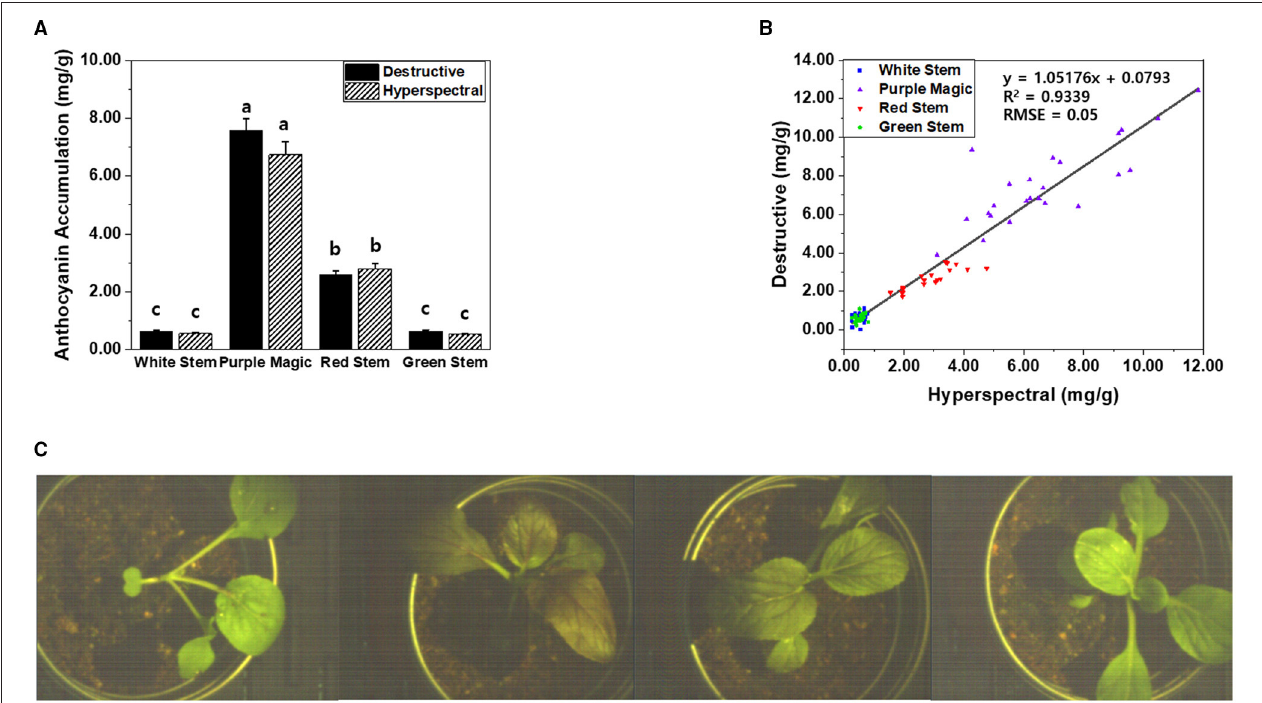
FIGURE 5 | (A) Comparison of anthocyanin accumulations (mg/g DW) obtained by destructive analysis and hyperspectral analysis from the whole plant of four bok choy cultivars grown under the SC at GS1. These data were obtained from the third experiment described in the Materials and methods section. Means with a different letter are significantly different at P ≦ 0.05, using Fisher’s LSD analysis. (B) The linear relationship between hyperspectral imaging and destructive analysis data was obtained from the whole plant of four bok choy cultivars grown under the SC at GS1. (C) The representative hyperspectral image was taken at the whole plant level in four different bok choy cultivars (from the left white stem, purple magic, red stem, and green stem).